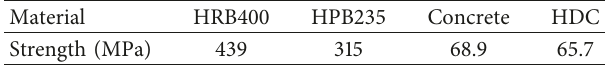
Table 4: Strength of materials.